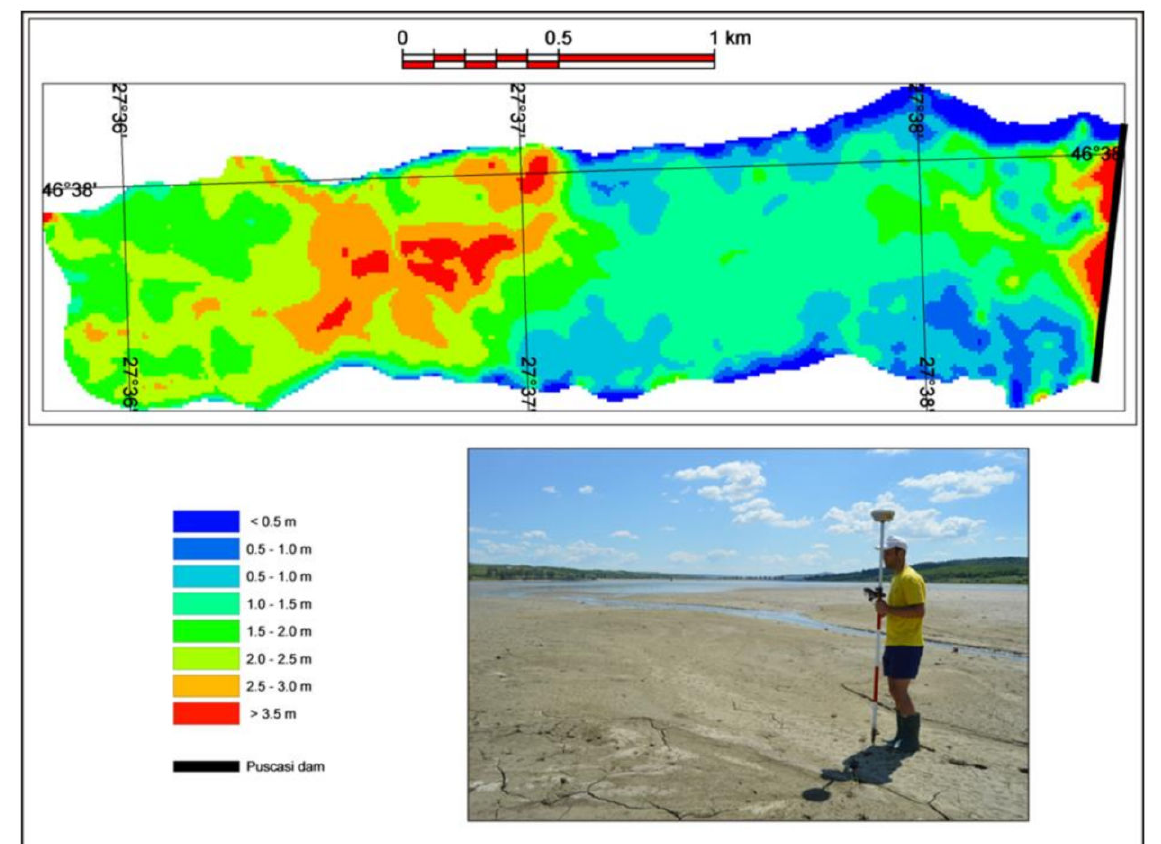
Figure 10. Map of sediment thickness within the Puscasi reservoir from the lower Racova catchment, Moldavian Plateau,